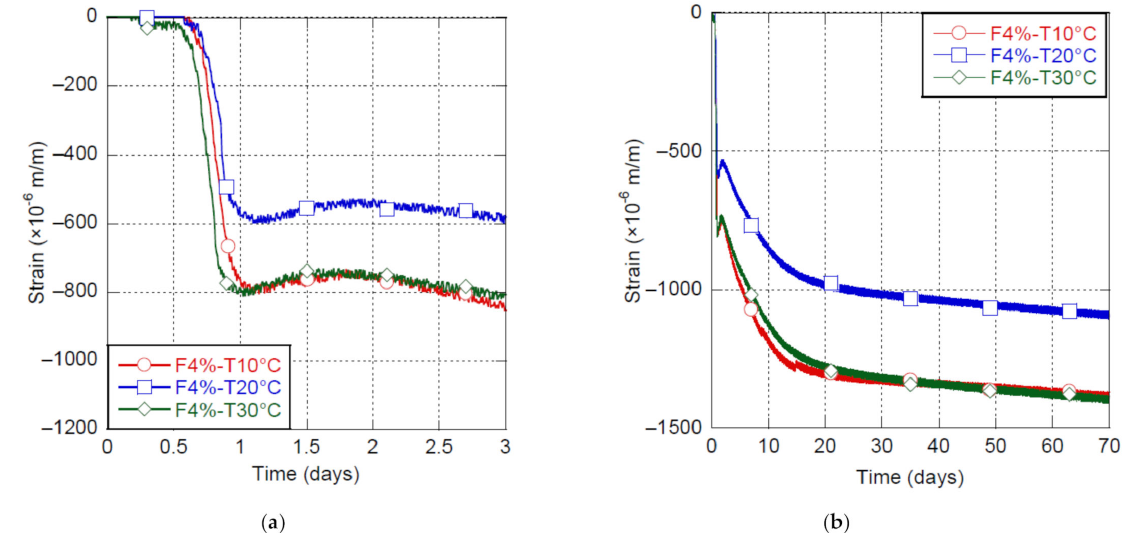
Figure 3. Shrinkage of UHPC-F4% at 10, 20 and 30 ◦ C mixing temperatures, ( a ) early-age shrinkage, ( b ) long-term